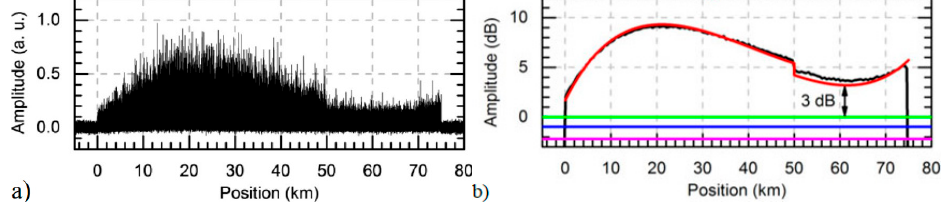
Figure 8. (From [27]) ( a ) Optical trace of CP- Φ OTDR using bidirectional first order Raman amplification over 75 km and ( b ) Corresponding optical SNR showing a minimum of 3 dB, allowing for a 1 n ε sensitivity (there defined by strain standard deviation, see Equation (13)) along the fibre, @2017 IEEE [27].